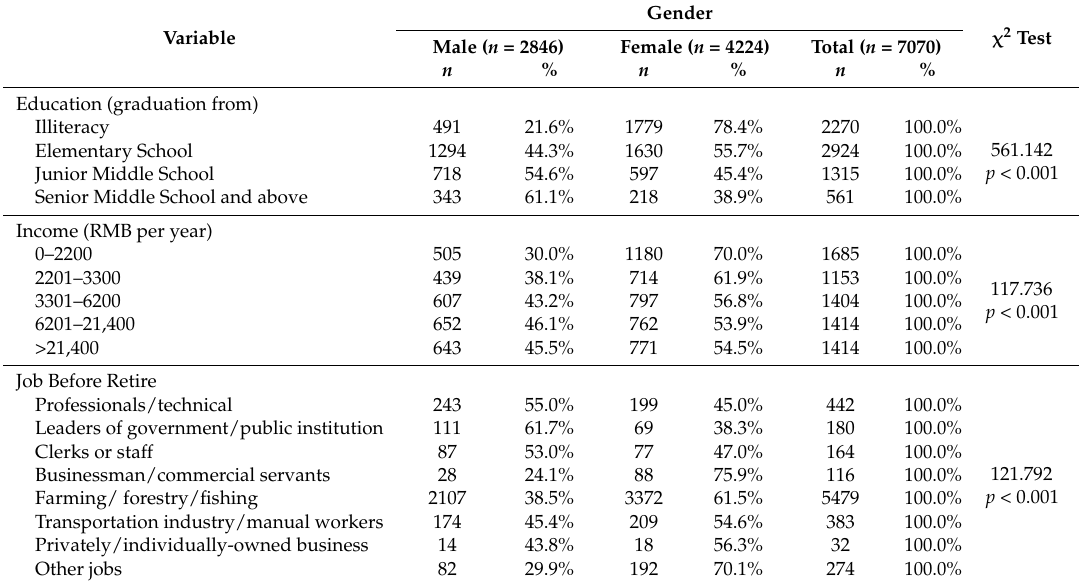
Table 3. Descriptive SES (socioeconomic status) Characteristic of Participants by Gender.